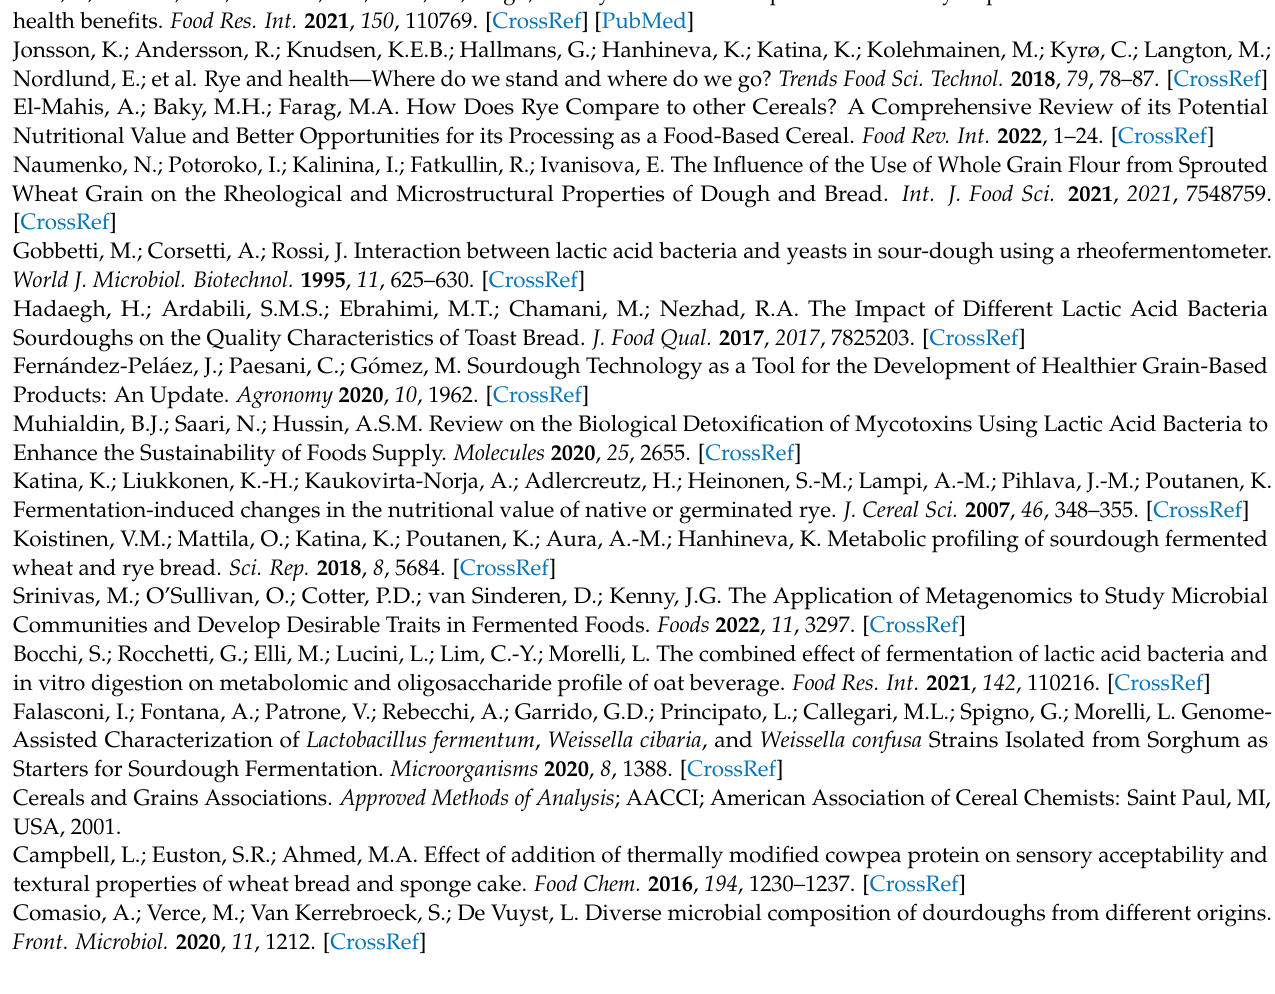
Table S5: List of VIP markers associated with the OPLS-DA model discriminating between starters of sprouted rye doughs (SC+LAB vs.